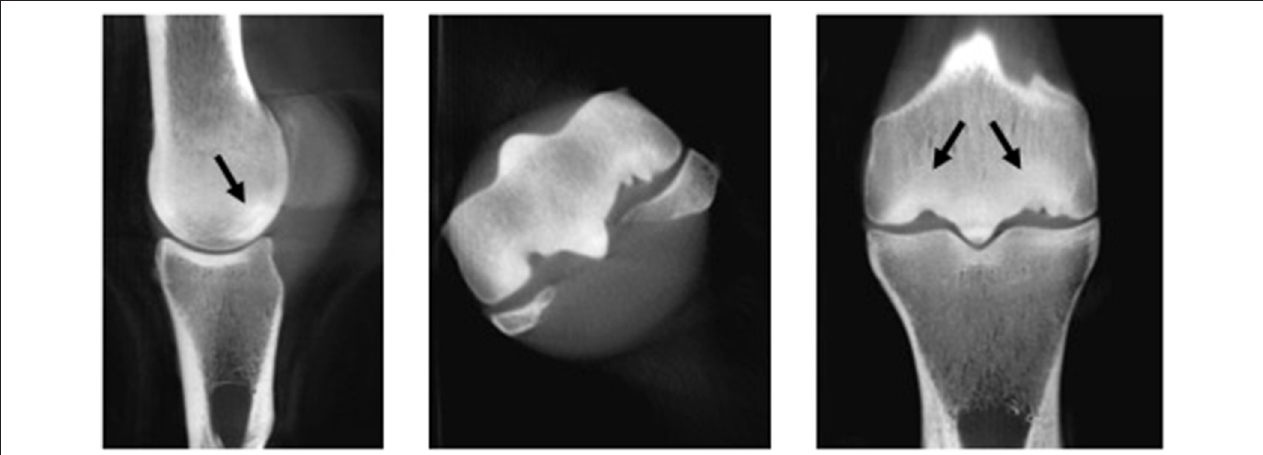
FIGURE 4 | Image of the distal metacarpus of a 10-year-old Thoroughbred racehorse obtained post-mortem with marked palmar osteochondral disease obtained using computed tomography (CT) in the sagittal, transverse and dorsal planes. Subchondral bone sclerosis and lysis (black arrows) and extensive articular cartilage loss is visible on these images and was present on gross